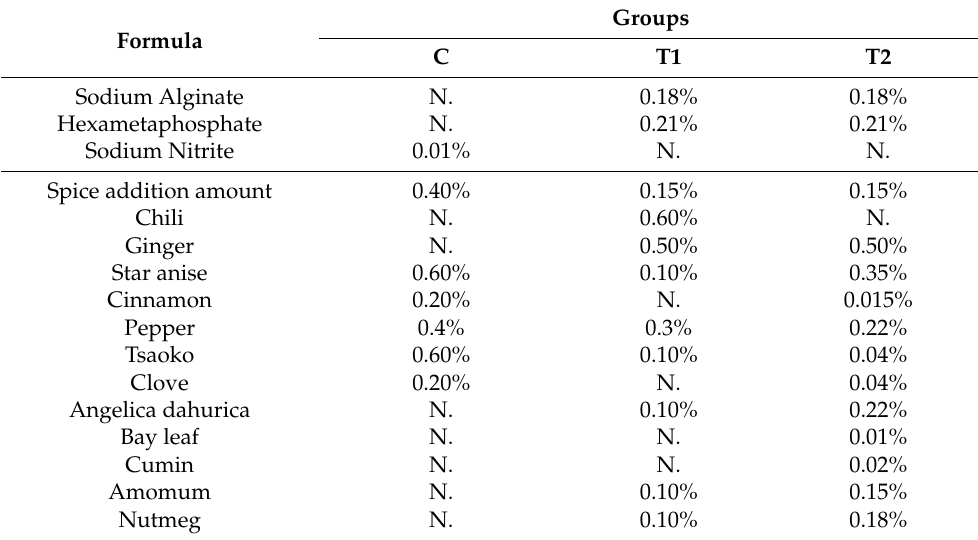
Table 1. Cont . Formula